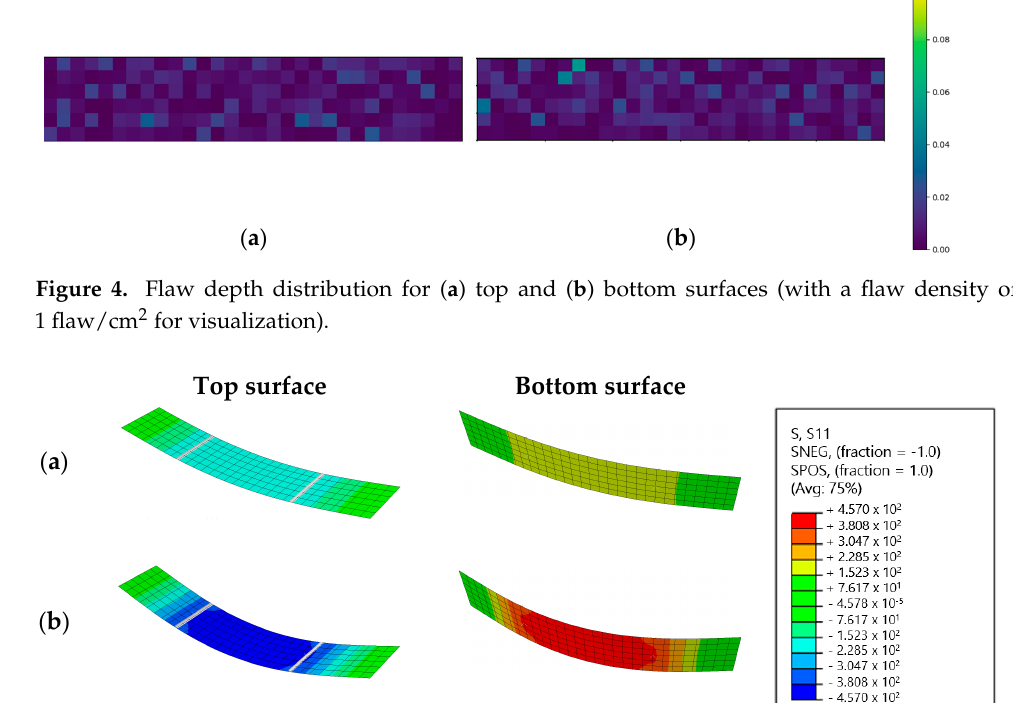
Figure 4. Flaw depth distribution for ( a ) top and ( b ) bottom surfaces (with a flaw density of 1 flaw/cm 2 for visualization).